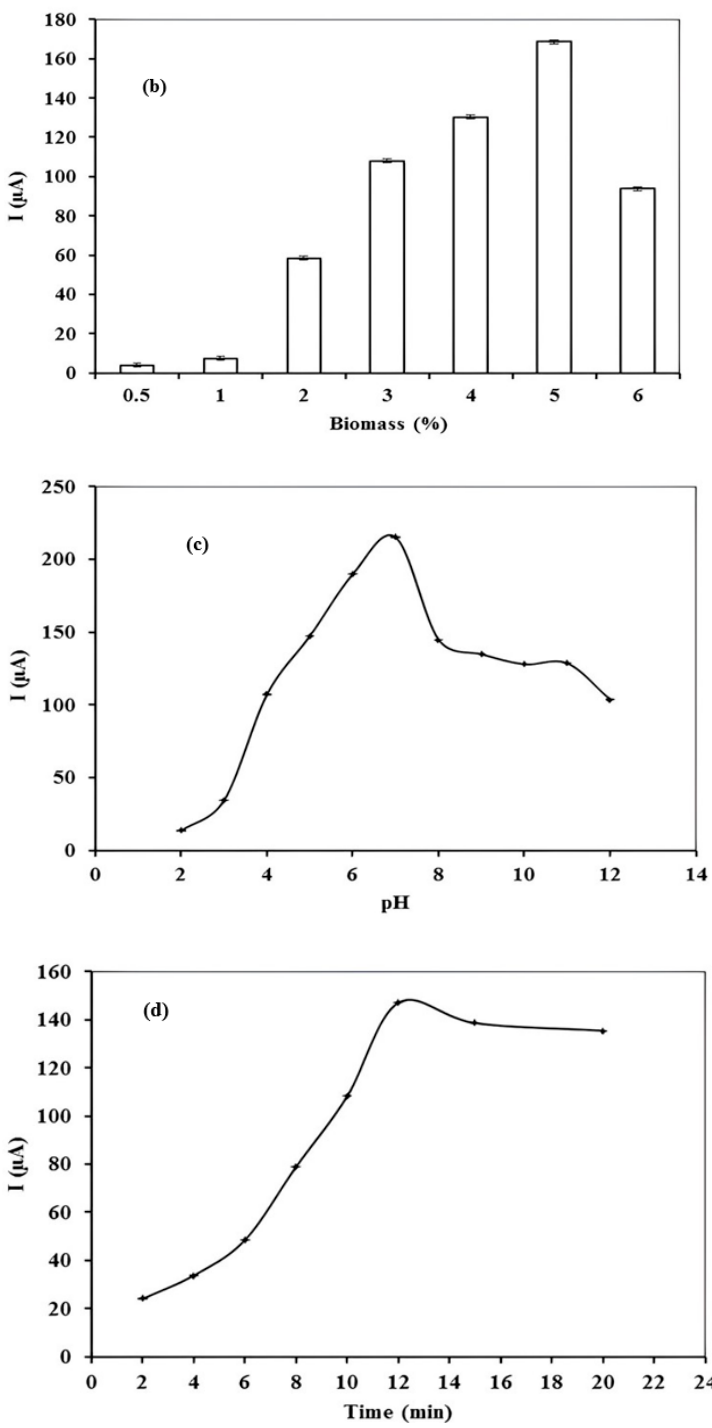
Figure 3. ( a ) Effect of deposition potential on stripping peak current value of 10 µgL − 1 Hg (II) at pH 7 with accumulation time of 12 min ( b ) Effect of biomass concentration (%) in modified carbon paste for 10 µgL − 1 Hg (II) at pH 7 with deposition potential − 0.7 V and accumulation time of 12 min ( c ) Effect of pH of accumulating medium on current value of 10 µgL − 1 Hg (II) stripping peak at deposition potential − 0.7 V, accumulation time of 12 min, and biomass concentration 5% ( d ) Effect of accumulation time on stripping peak current value of 10 µgL − 1 Hg (II) with pH 7, deposition potential − 0.7 V, and biomass concentration 5%.